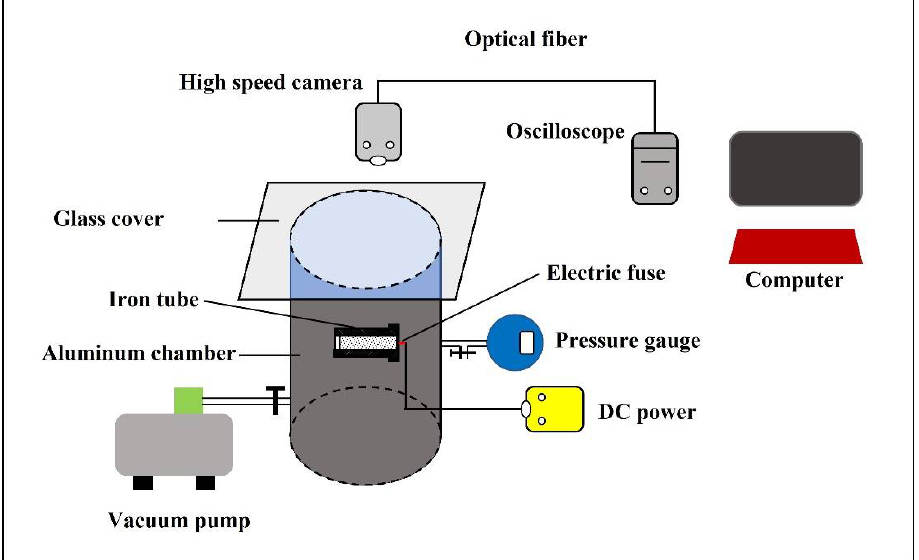
Figure 3. Schematic diagram of the burning rate test